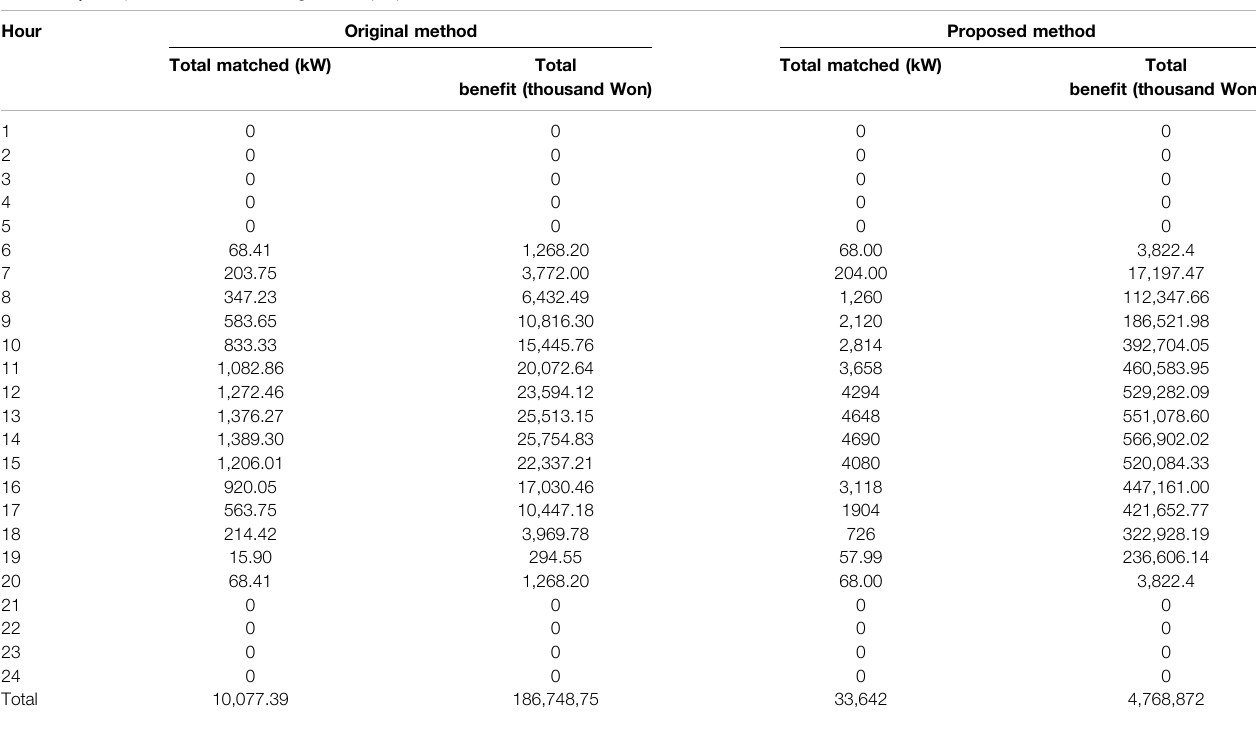
TABLE 3 | Comparison of results of original and proposed methods: Case